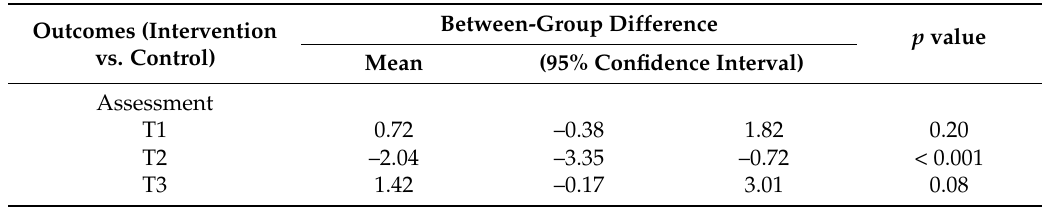
Table 4. Mixed-linear model-based estimates of change in the FES-I